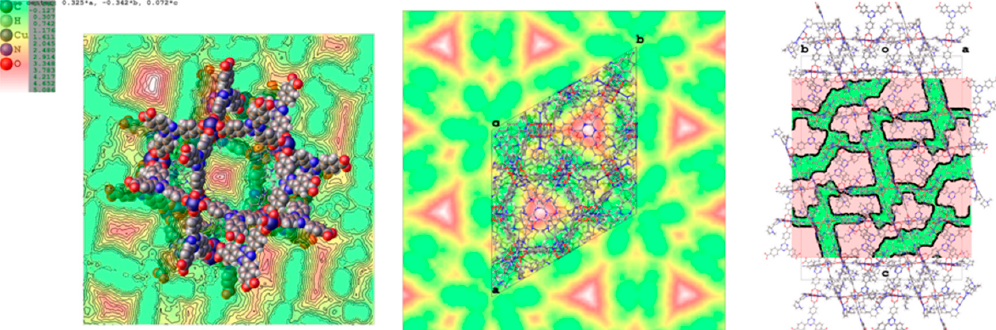
Figure 6. Maps of the voids in PCN-6@nicotine, where the unstructured residual electron density has been detected. ( Left ) Void present in pore A; ( centre ) map of the voids in the unit cell projected down the c axis; ( right ) mask of the accessible voids in the unit cell mapped down [110]. By considering a loose packing efficiency of 50% of nicotine inside the cavities, it can be roughly estimated that the unit cell contains about 100 nicotine molecules (molecular volume = 180 Å 3 , 88 electrons) not directly coordinated to the copper atoms, resulting in approximately 9000 electrons,